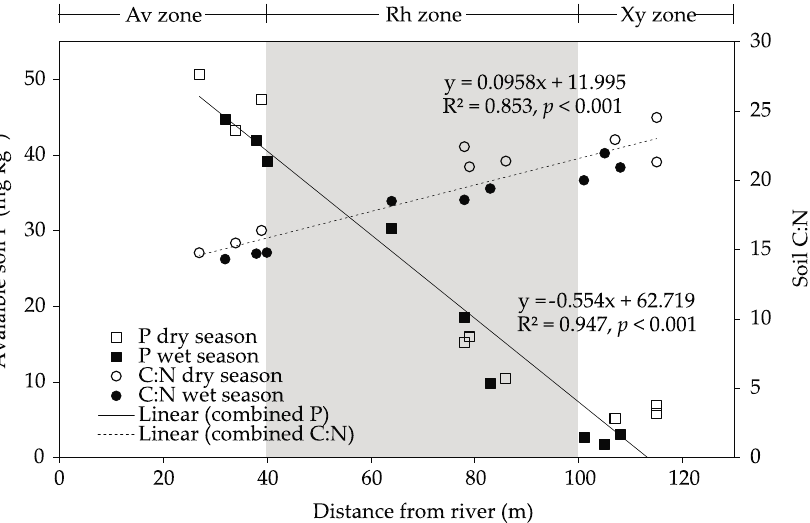
Figure 5. The relationships between soil nutrient parameters (available P and C:N ratio) and distance from the river across the zonation: Avicennia (Av), Rhizophora (Rh), and Xylocarpus (Xy) zones.